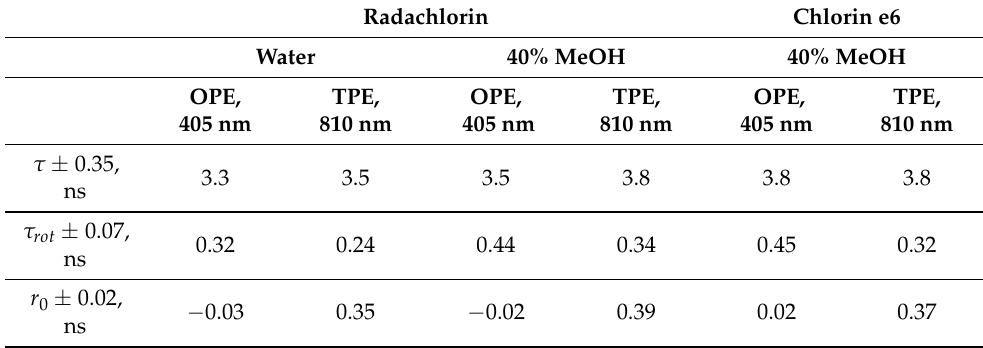
Table 1. Fluorescence parameters of Radachlorin and chlorin e6 at one- and two-photon excitation. Radachlorin Chlorin e6